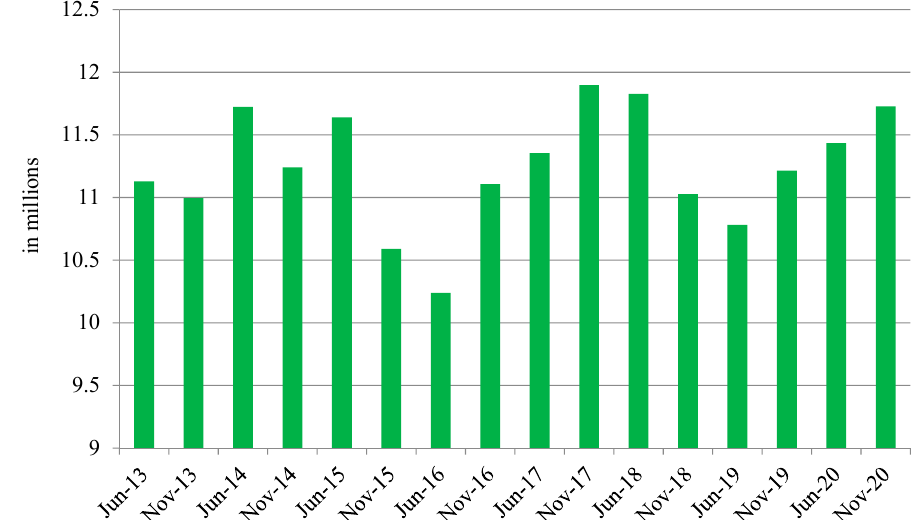
Figure 6. Pig population in Poland in 2013–2020. Source: Central Statistical Office.